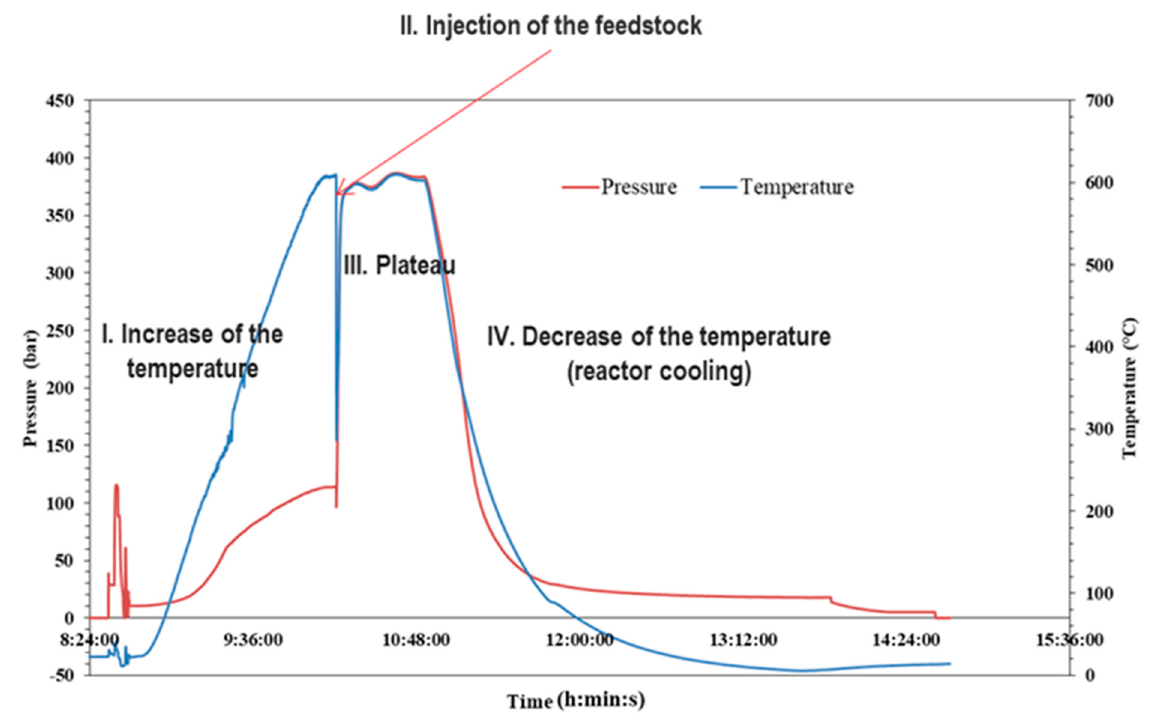
Figure 3. Temperature and pressure profiles of the SCWG process.